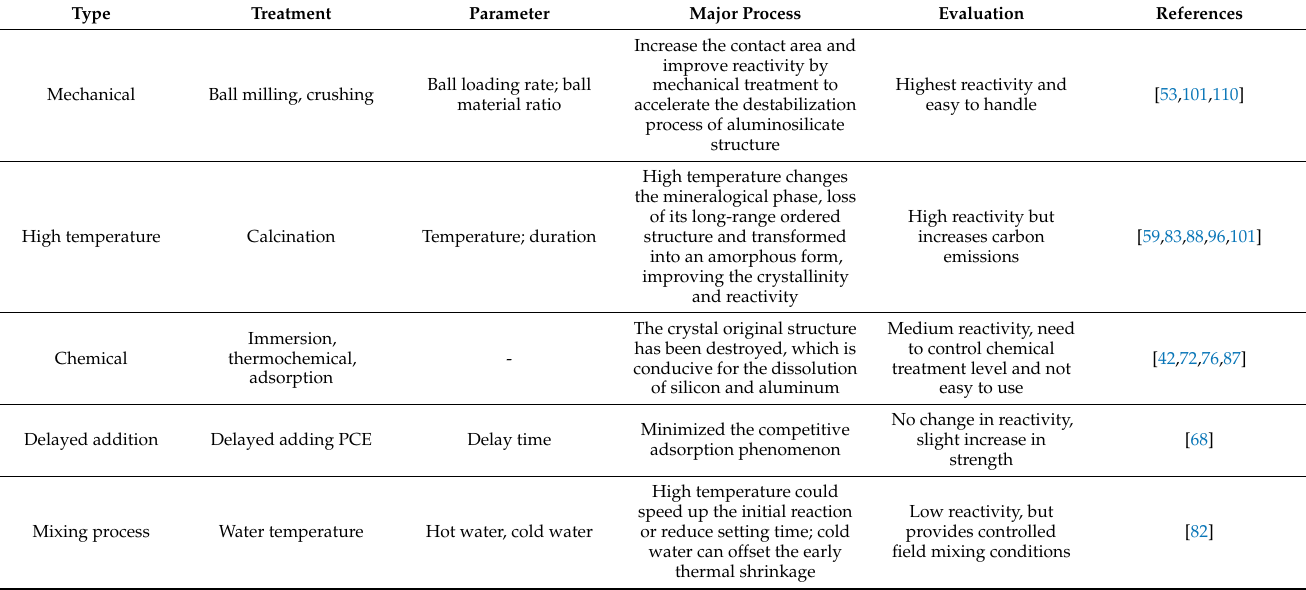
Table 2. Common treatment processes and their